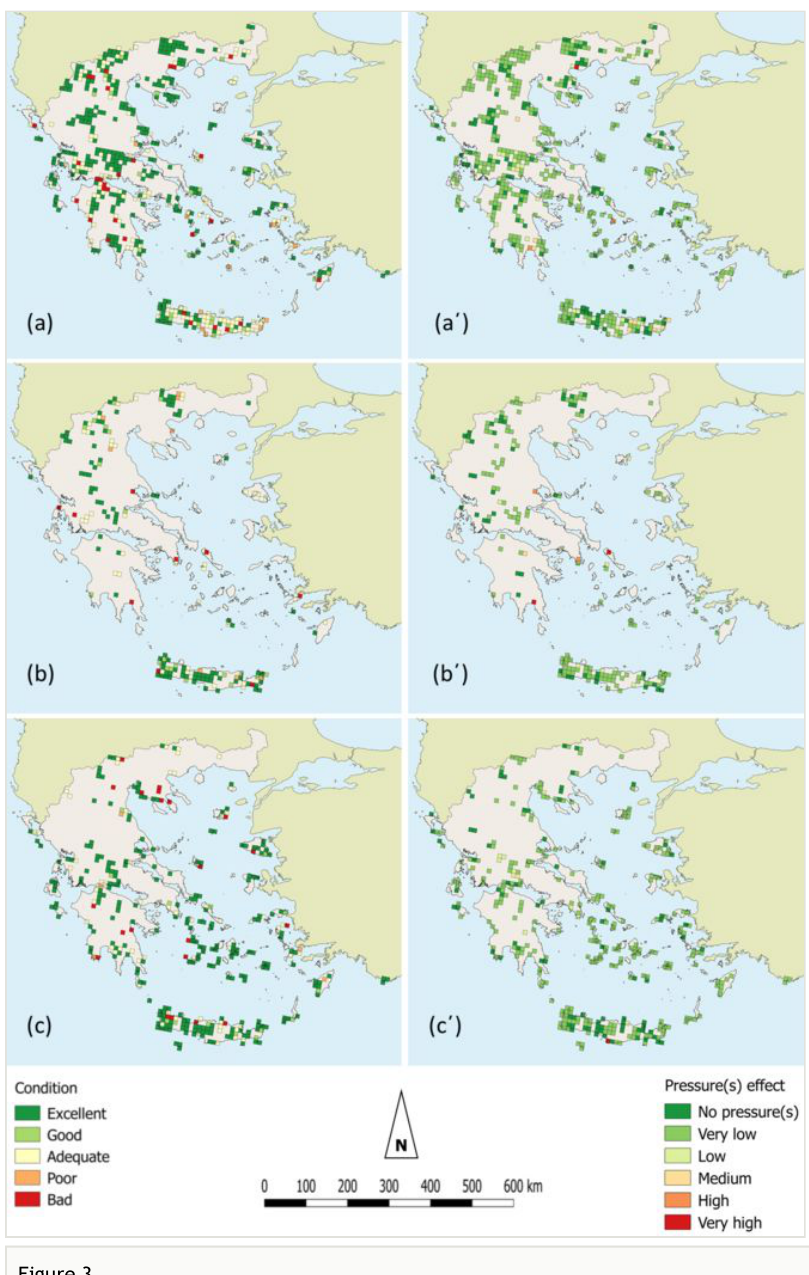
Figure 3. Mapping of the ecosystem types’ condition (EEA 10 km grid cell analysis) for: (a) grasslands, (b) woodland and forests, (c) heathland and shrub. Pressure(s) cumulative e ff ect for each ecosystem type is presented in plates (a ΄ ), (b ΄ ) and (c ΄ ),